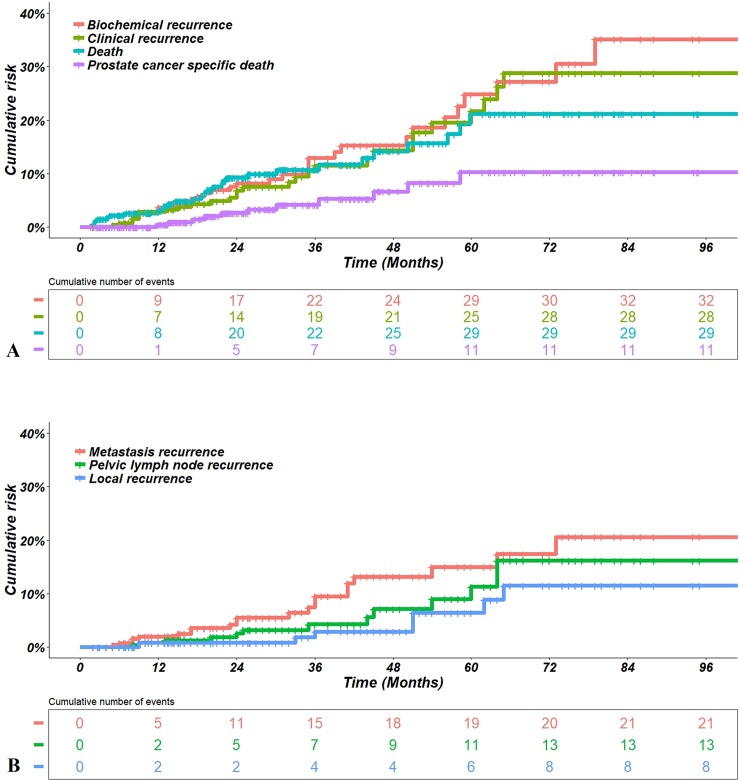
Carcinological results for T3b prostate cancer patients.(A)Results for biochemical and clinical recurrences and deaths. (B) Results for clinical recurrence detailed by local recurrence as the first event (local, pelvic lymph node, and metastasis). Clinical recurrence was defined as at least local or pelvic lymph node or metastasis recurrence.